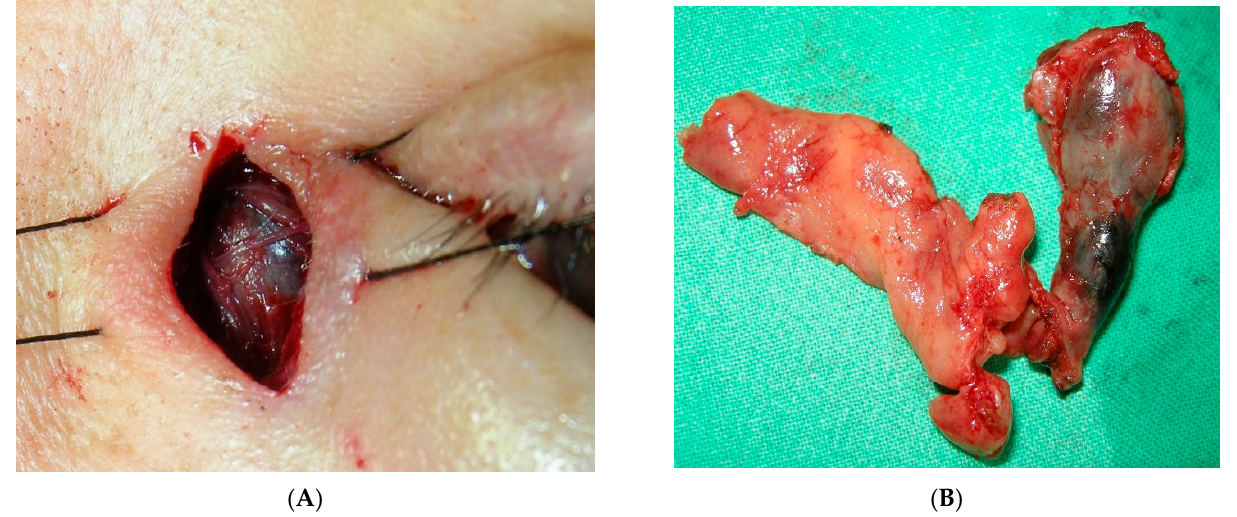
Figure 3. Lacrimal sac melanoma. ( A ) One black-pigmented mass noted over left lacrimal sac. ( B ) Wide excision of lacrimal sac and nasolacrimal duct tumor with adjacent soft tissue.